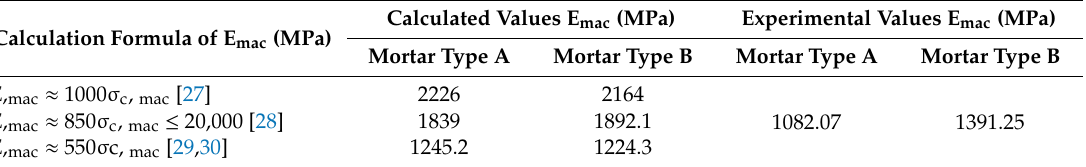
Table 4. Comparison of experimental results Young’s modulus (E) with analytical predictions.